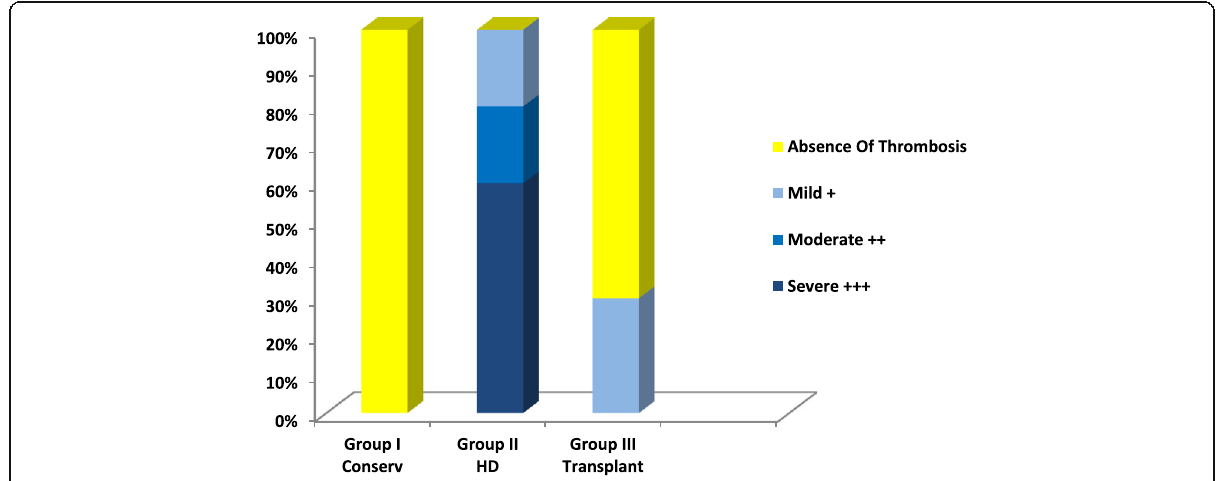
Fig. 3 Frequency distribution of cases according to thrombosis score